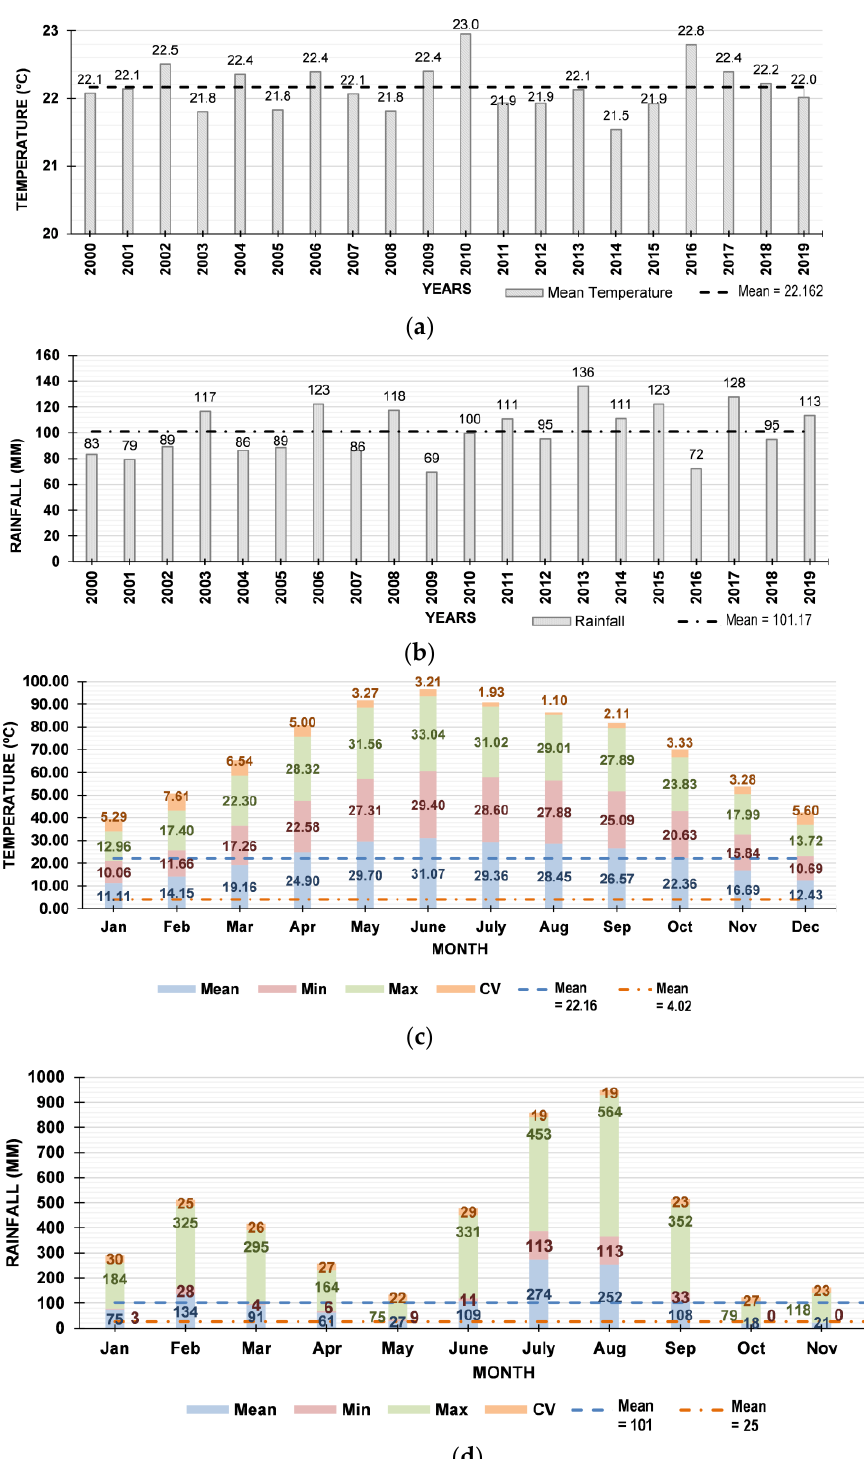
Figure 3. Statistical specifics of historical annual and monthly temperatures and precipitation. ( a ) Mean annual temperatures, ( b ) Mean annual rainfall, ( c ) Monthly temperatures from 2000 – 2019, ( d ) Monthly rainfall from 2000 – 2019. The abbreviation ‘ CV ’ refers to the coefficient of variation, and other abbreviations used are as per